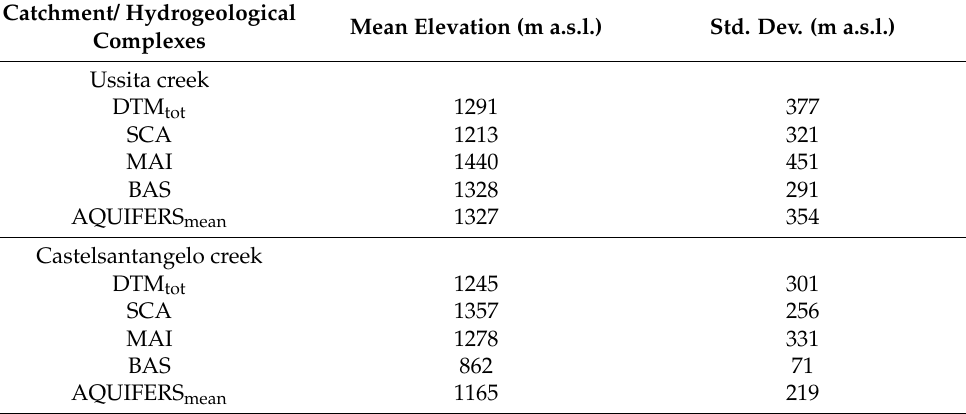
Table 2. Mean and standard deviation values for the elevation of each basin and each aquifer outcropping into the study area determined by the GIS